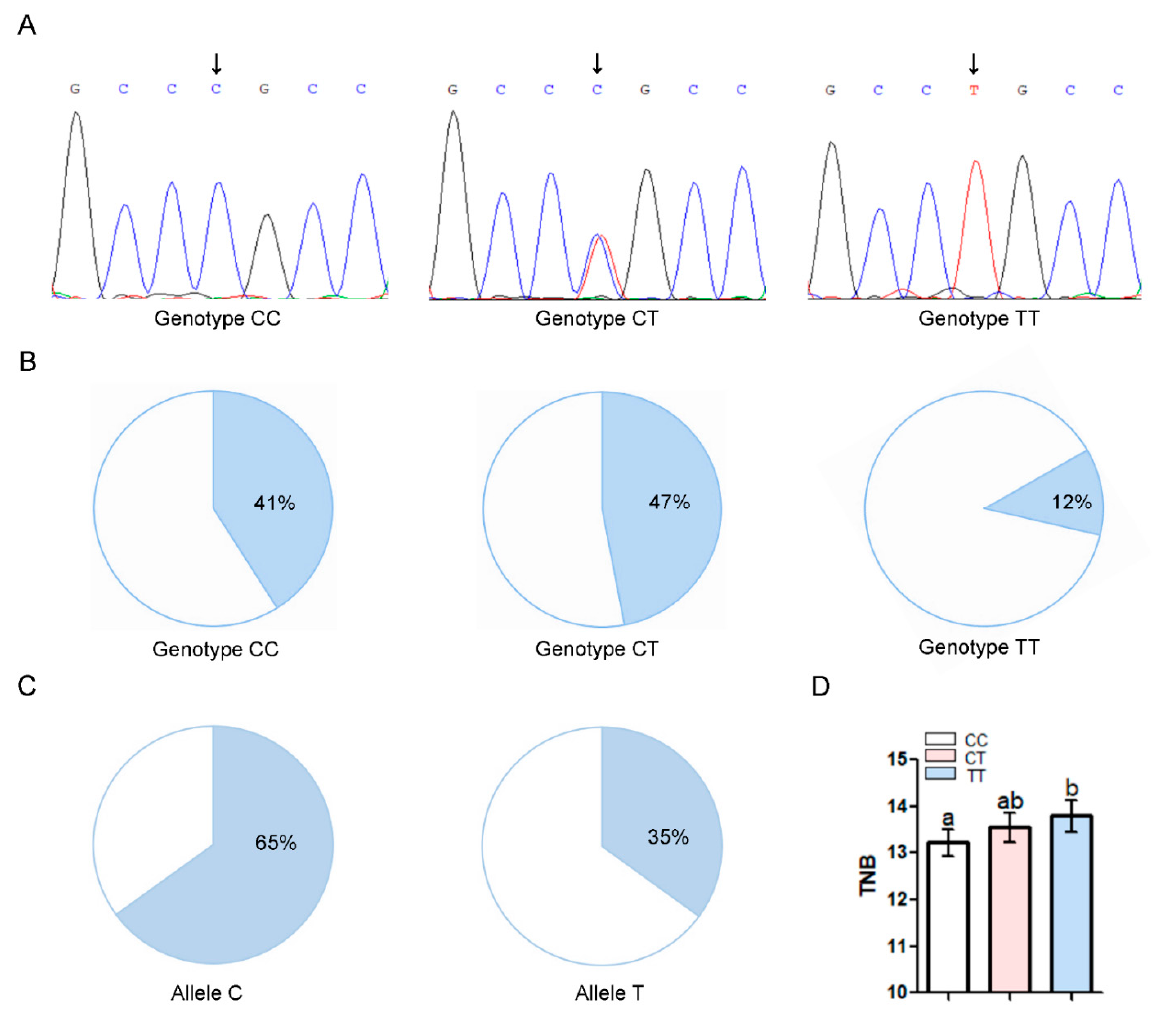
Figure 7. The SNV g. − 398C>T within the miR-23a core promoter is associated with sow feritility traits. ( A ) Peak plot of g. − 398C>T. ( B ) Genotype frequency of the SNV g. − 398C>T in a Large White sow population ( n = 346). ( C ) Allele frequency of the SNV g. − 398C>T in a Large White sow population ( n = 346). ( D ) Association analysis between the SNV g. − 398C>T and TNB of sows for multiparities. Data are expressed as the least-squares mean ± S.E.M., n = 346, and significance was tested using a GLM program. Significant differences between groups ( p < 0.05) are indicated by different lowercase letters, and insignificant differences ( p > 0.05) are indicated by the same letter.